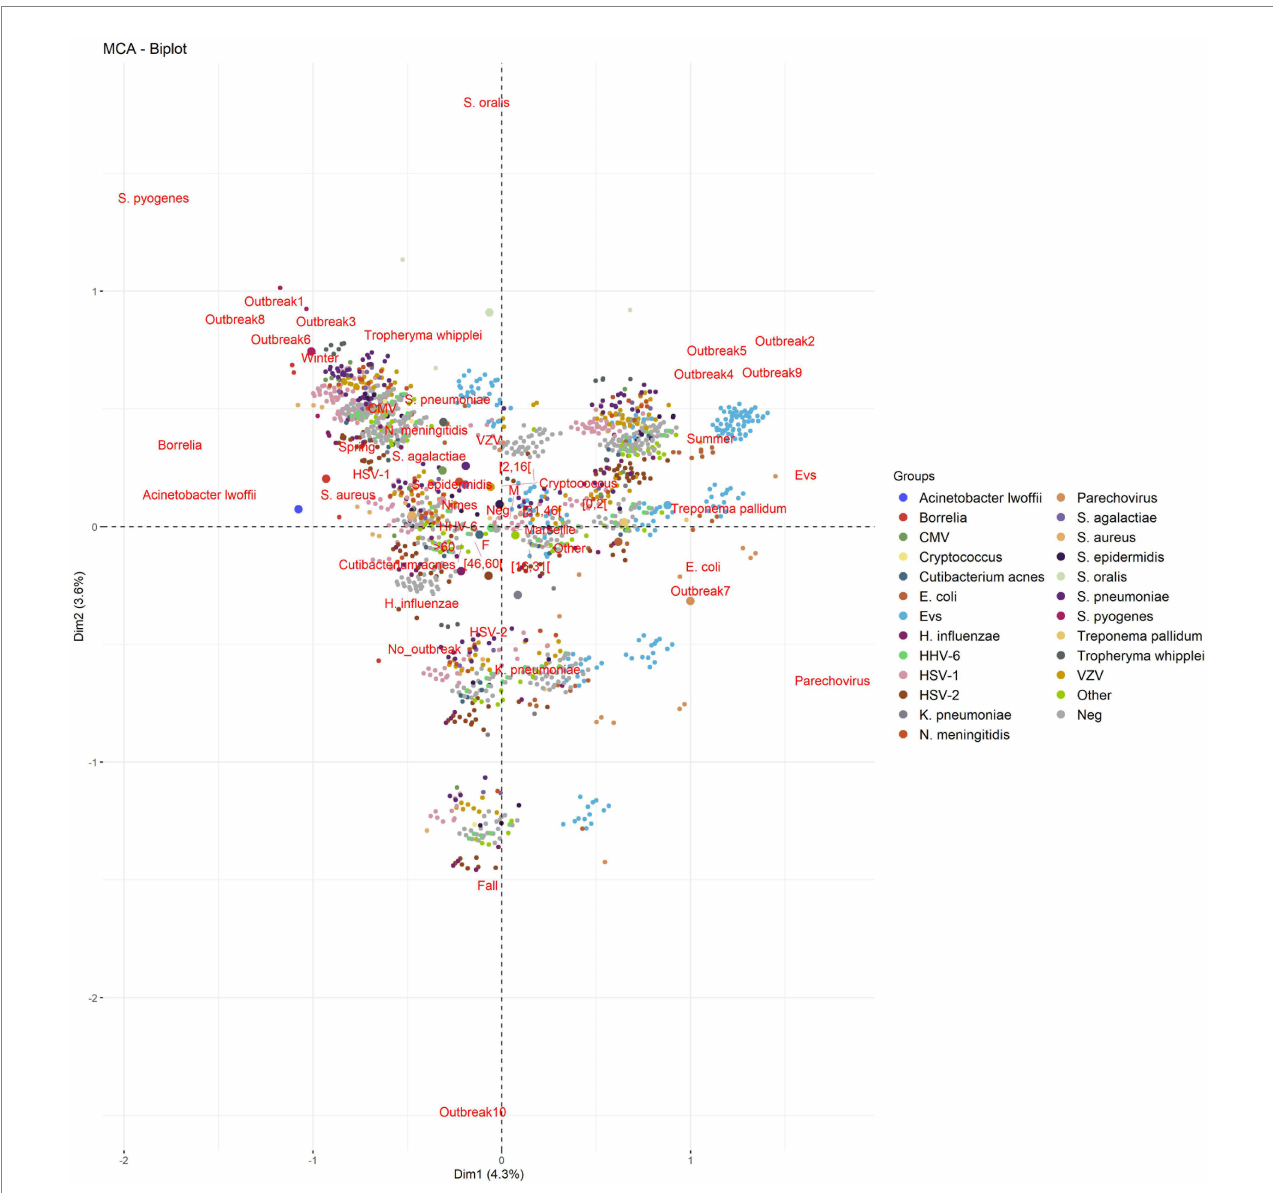
FIGURE 3 Multiple correspondence analysis of positive/negative (documented/undocumented) cases, pathogens, and season according to the different outbreaks. Infections in Marseille were more closely associated with summer outbreaks and younger patients, whereas infections in Nîmes were more associated with winter outbreaks and older patients, mostly HSV-1, HSV-2, VZV, and Haemophilus influenzae . There was no notable difference concerning